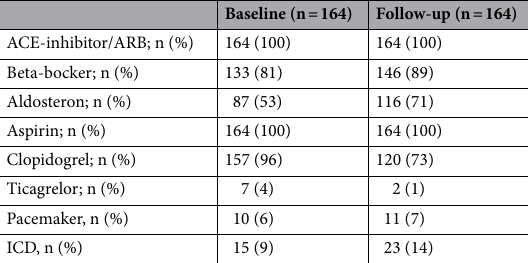
Table 3. Traetmernt at baseline and follow-up.